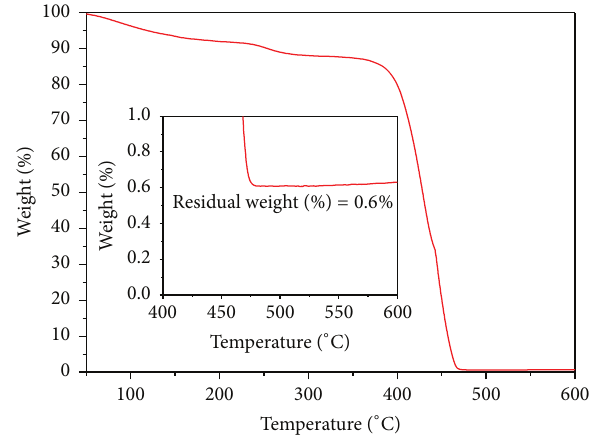
Figure 3: TGA in air of palladium clusters embedded in PVP produced by reduction of [PdCl 4 ] 2− at 90 ∘